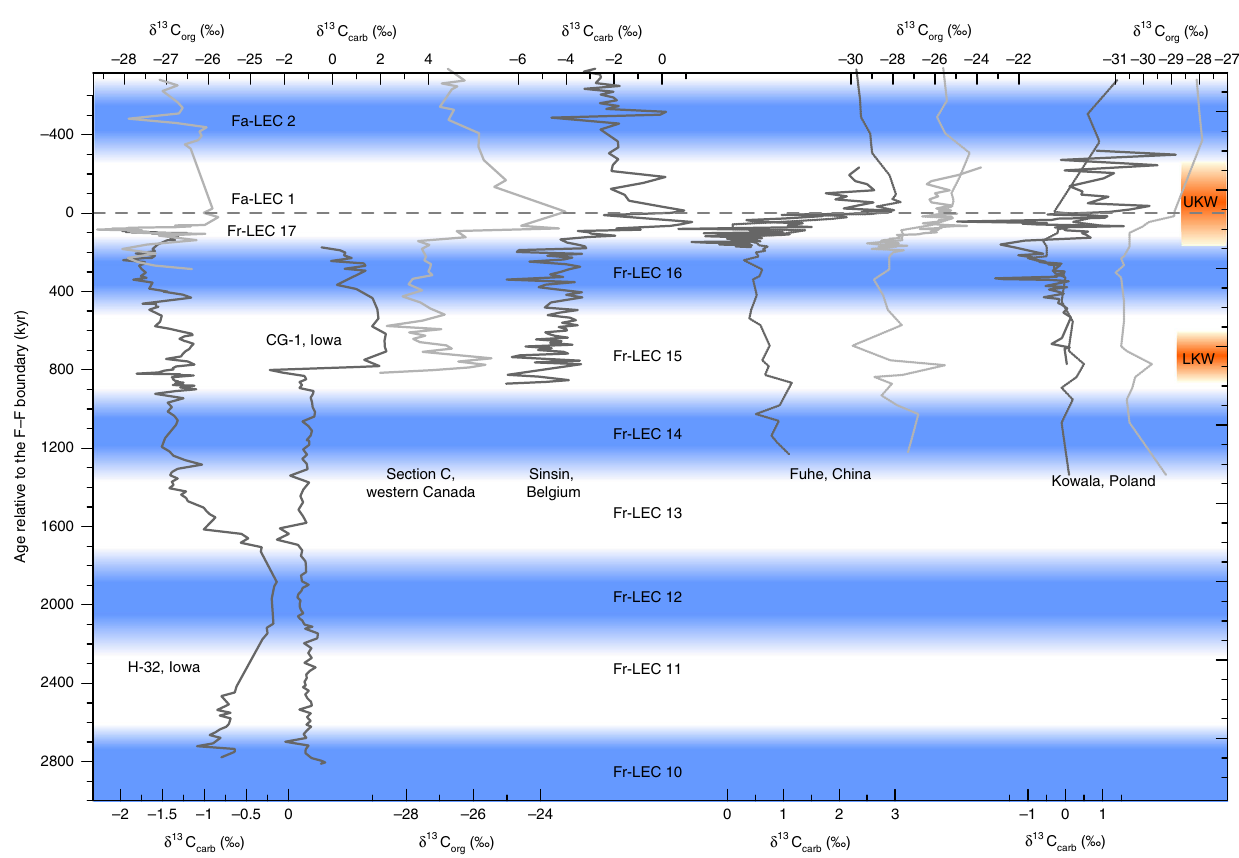
Fig. 3 Late Frasnian – earliest Famennian carbon isotope geochemistry from globally distributed sections along a common astronomically constrained relative timescale. The H-32, CG-1, Sinsin, and Fuhe records have been tied-in into the Frasnian astrochronologic framework for Section C (western Canada) and Kowala (Poland), based on distinct features in magnetic susceptibility and carbon isotope geochemistry (Figs. 5 and 6). The Frasnian astrochronogic framework counts 16.5 long 405-kyr eccentricity cycles (Fr-LEC) 15 – 17 . The fi rst Famennian 405-kyr cycle (Fa-LEC 1) is the same cycle as Fr- LEC 17. UKW upper Kellwasser, LKW lower